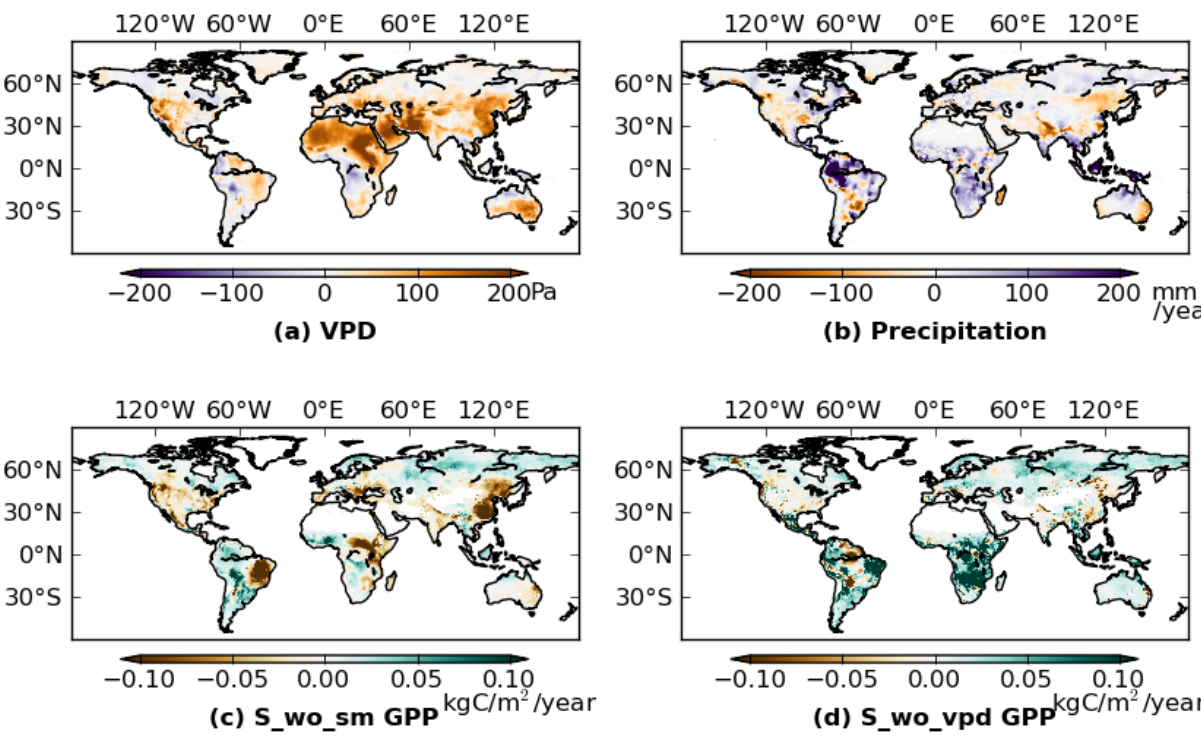
Figure 4. Difference of mean Vapor Pressure Deficit (VPD), precipitation, and Gross Primary Production (GPP) between 2000–2009 and 1982–1999. Panel ( a ) is annual mean VPD difference, and Panel ( b ) is annual total Precipitation difference. Panel ( c ) is the difference of annual total GPP of the simulation without-soil moisture ( S_wo_sm ), and Panel ( d ) is that of the simulation without-VPD ( S_wo_vpd ). The climatology of fPAR was used for all the simulations.